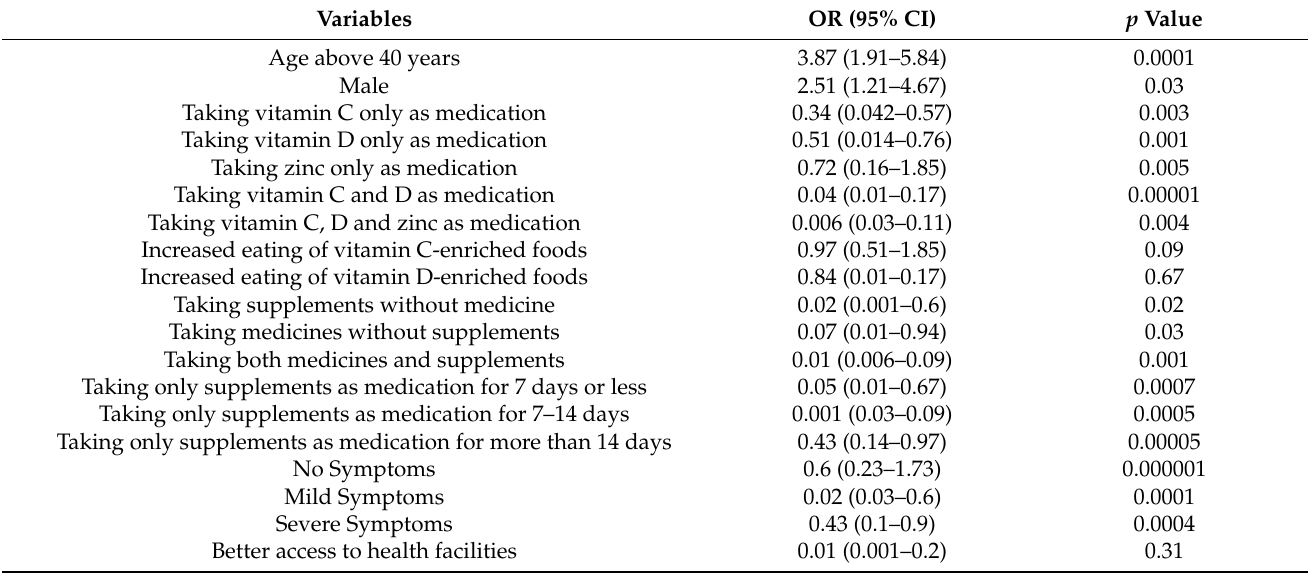
Table 4. Impact of vitamins and different variables with infection rate of COVID-19 among